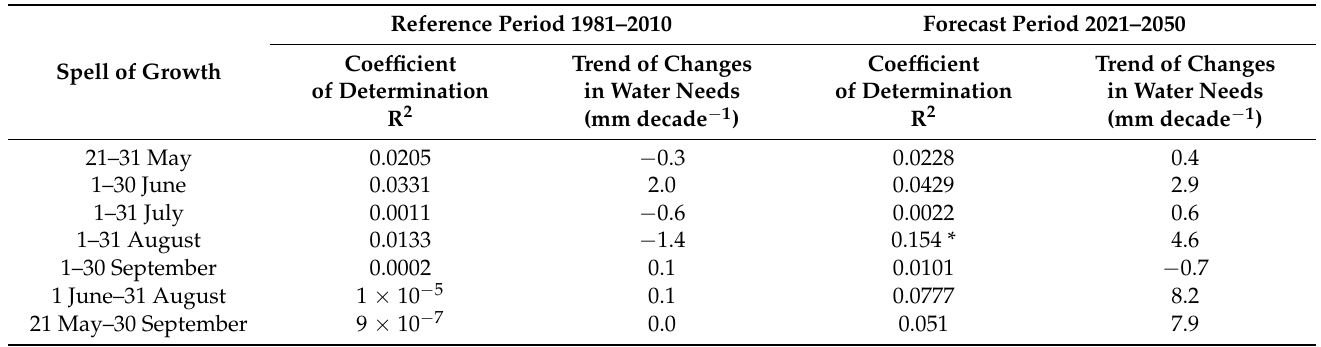
Table 4. The coefficient of determination and the tendency of changes in the giant miscanthus water needs during its specific spells of growth in the reference and forecast years.